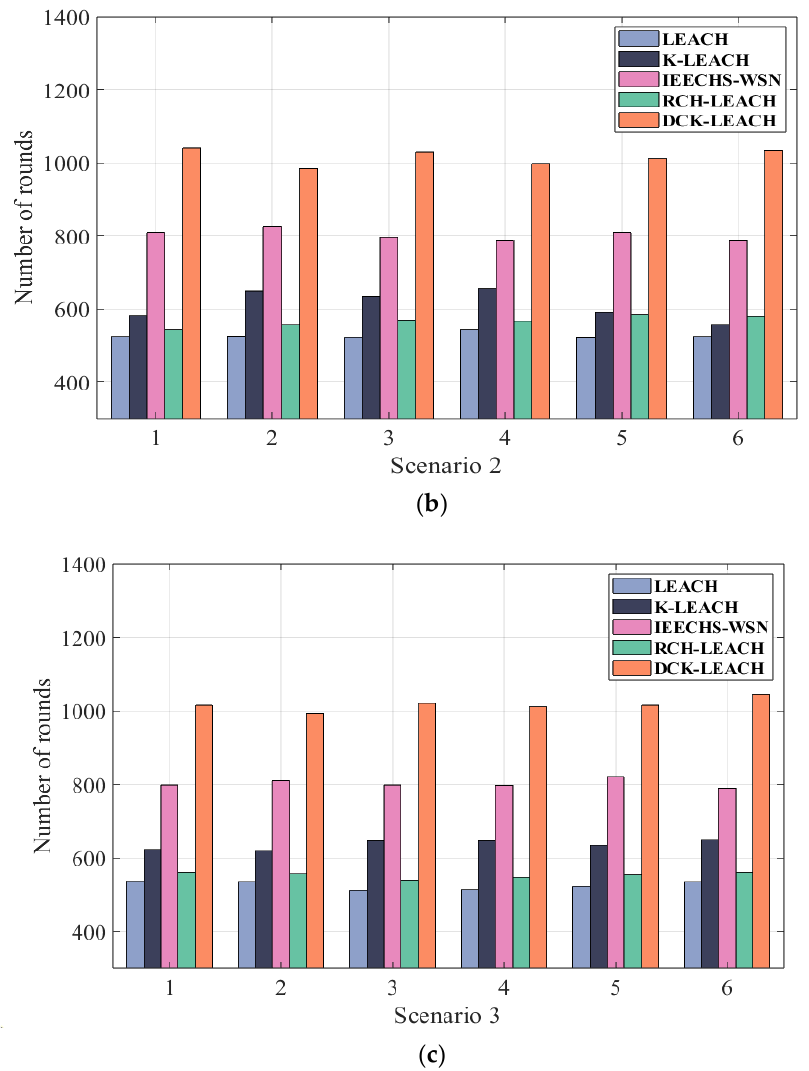
Figure 5. Comparison lifetime of the network in three scenarios: ( a ) 100 nodes, ( b ) 200 nodes, ( c ) 300 nodes. In x-axles of the figure, numbers 1, 2, 3, 4, 5, and 6 are the experiment IDs of multiple executions of the algorithm. Due to space limitations, we only listed the results of six experiments. Other multiple experiment results are similar and are not listed here.